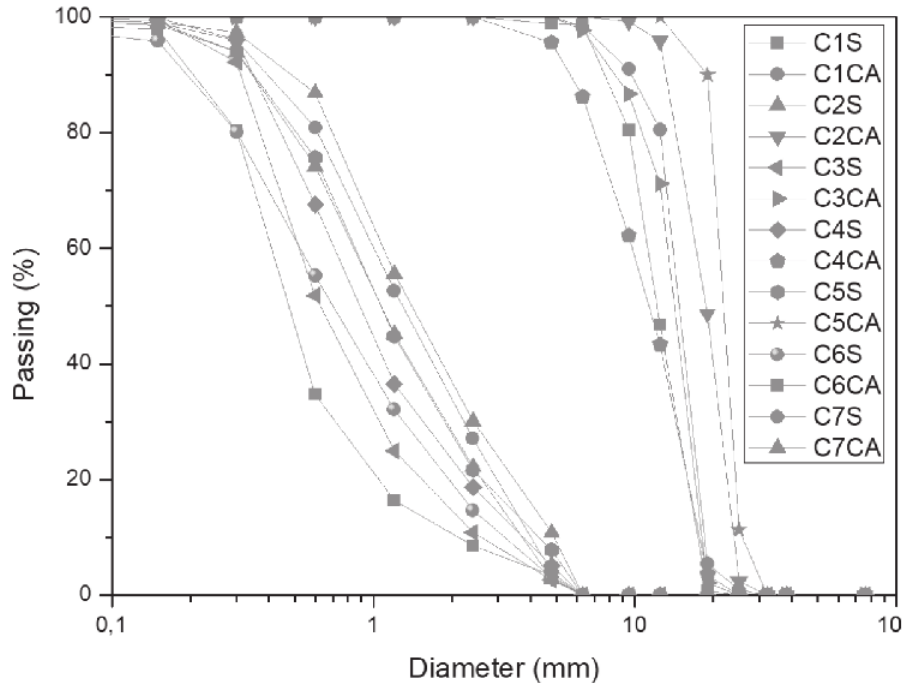
Particle size distribution of the aggregates employed in the concrete